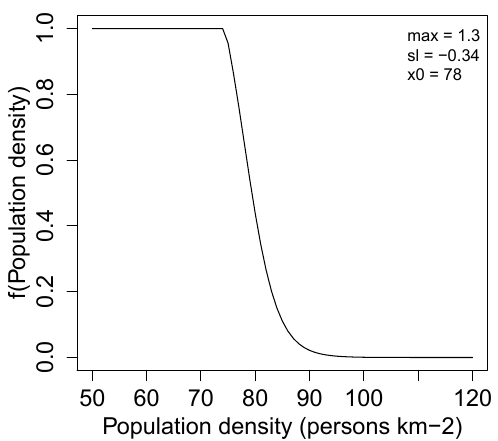
Figure A4. The response function from the best SOFIA model in- cluding population density (SF.314511) globally shows a decline in fire activity with increasing population density, a finding which is in agreement with independent studies (Andela et al., 2017; Bistinas et al., 2014; Knorr et al.,